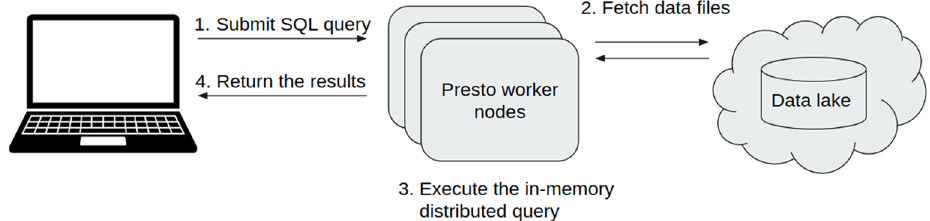
Figure 5. Overview of how the query engine and the Data Lake work together. This schematic represents the different steps, how a user can submit an analytical SQL query and a summary of the workflow of this query until the results are returned to the